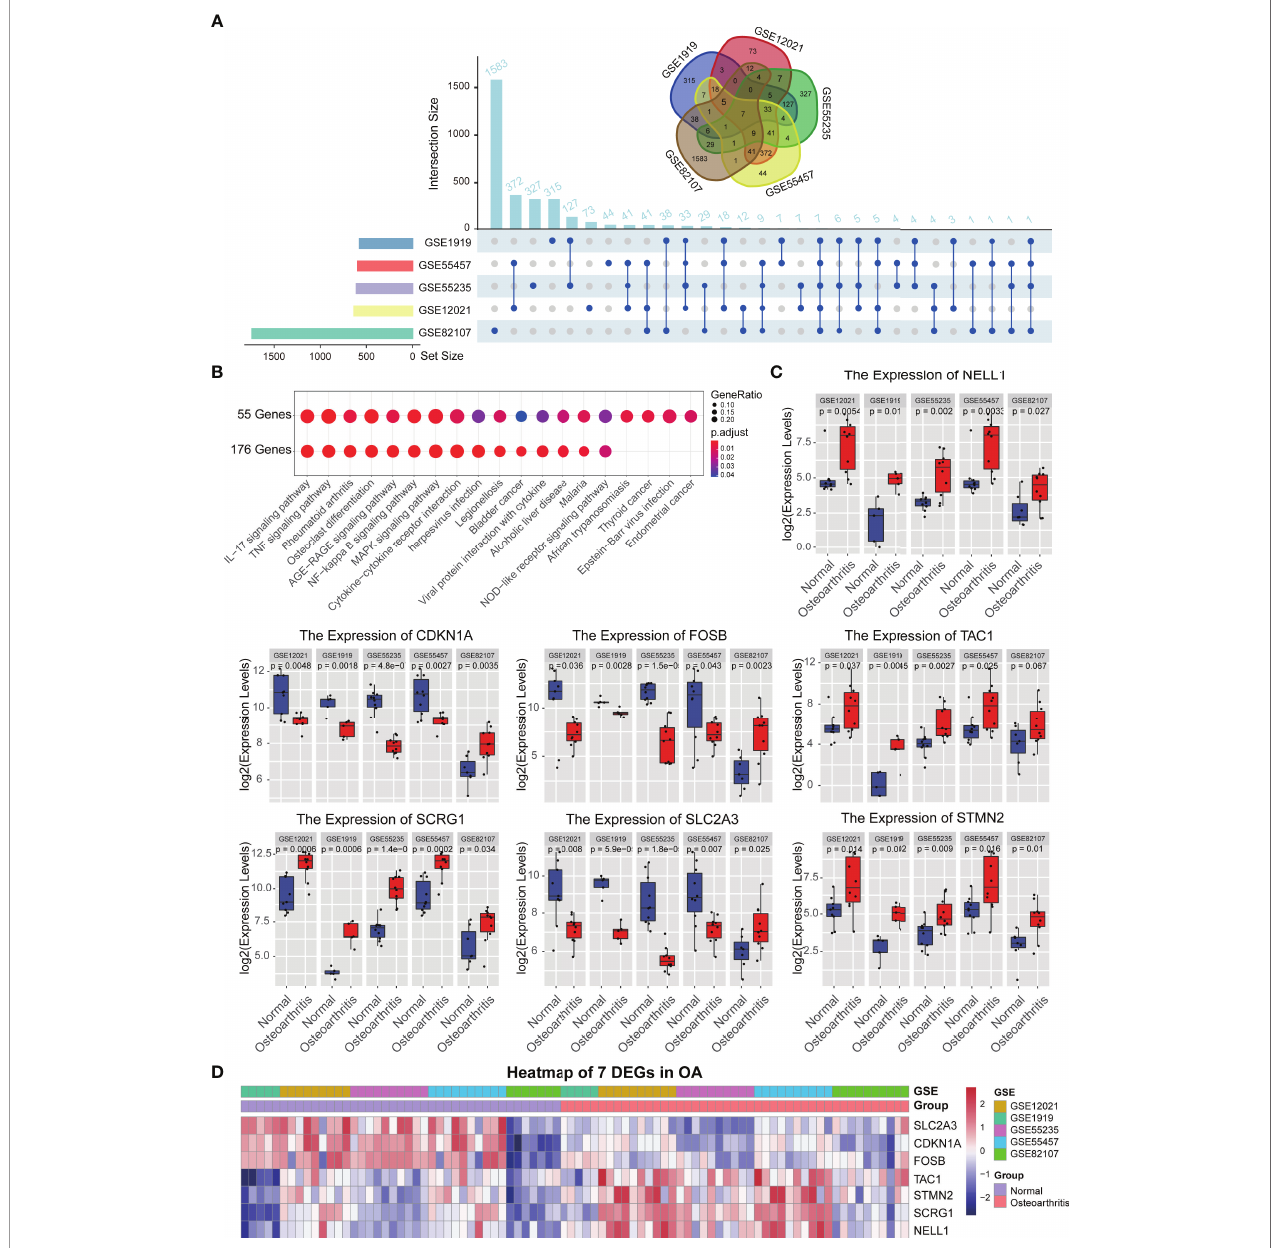
FIGURE 1 | Differential expression gene analysis. (A) The different analysis results of 5 synovium-related GEO data sets, upset and Venn diagram showed the relationship between the number of different genes in different GEO datasets. (B) KEGG function analysis of each gene sets. (C) Boxplot showed the expression levels of 7 genes which are commonly differentially expressed between synovial tissues and normal tissues in 5 GEO datasets. (D) A heatmap plot of 7 common differentially expressed genes in all synovial tissues and normal